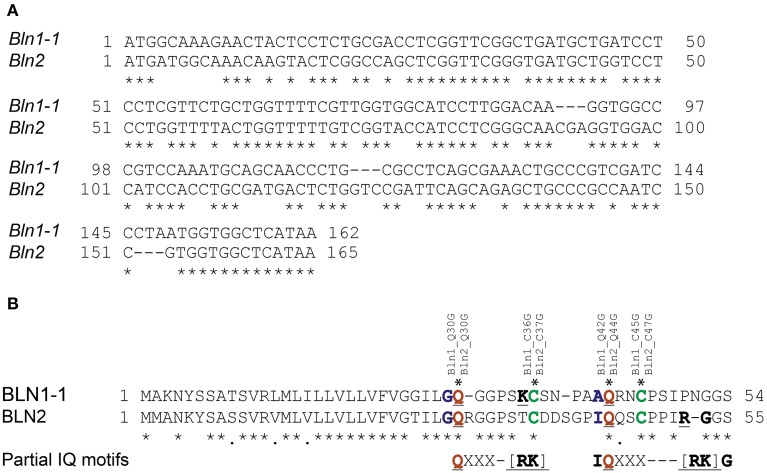
Alignment of
Bln1
and
Bln2
with the positions of conserved cysteines and potential partial IQ motifs. (A) Nucleotide alignment of Bln1 and Bln2 open reading frames. A “*” indicates conserved nucleotides. (B) Amino acid alignment of BLN1 and BLN2. The conserved glutamines (Q) in the partial IQ motifs are shown in red (with blue adjacent), cysteines (C) are shown in green. The conserved amino acids in potential partial IQ motifs (compared to the complete consensus [FILV]Qxxx[RK]Gxxx[RK]) are underlined. For BLN1, Q to G mutations were inserted at amino acid residues 30 and 42, and C to G mutations at residues 36 and 45. For BLN2, Q to G mutations were inserted at amino acid residues 30 and 44, and C to G mutations at residues 37 and 47.